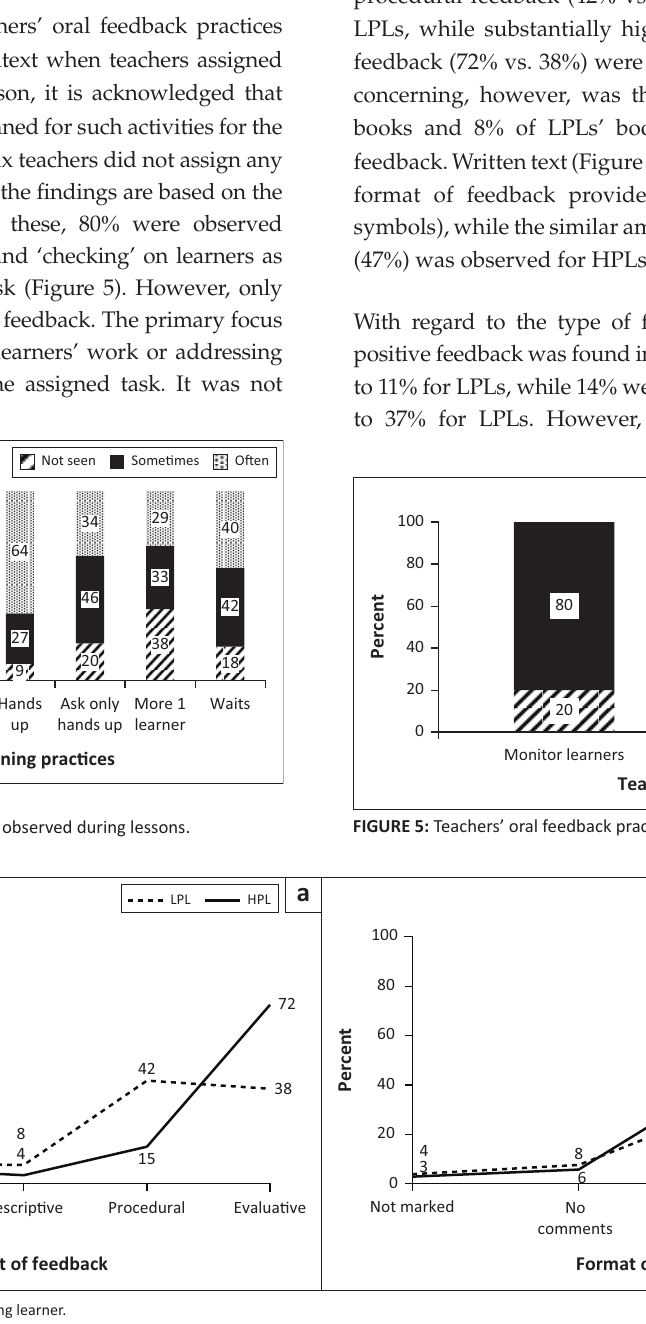
FIGURE 6: (a) Content of feedback for low- and high-performing learners; (b) Format of feedback for low- and high-performing learners.